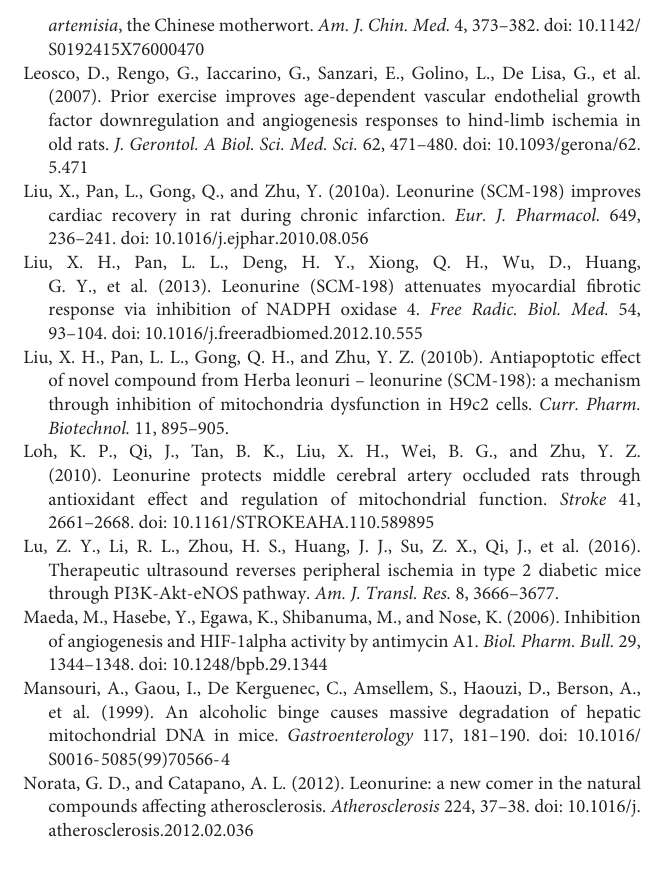
FIGURE S1 | Leonurine decreased cell senescence in HUVECs. (A) SA- β -gal staining in young and senescent HUVECs. (B) The effects of aging and leonurine on p21